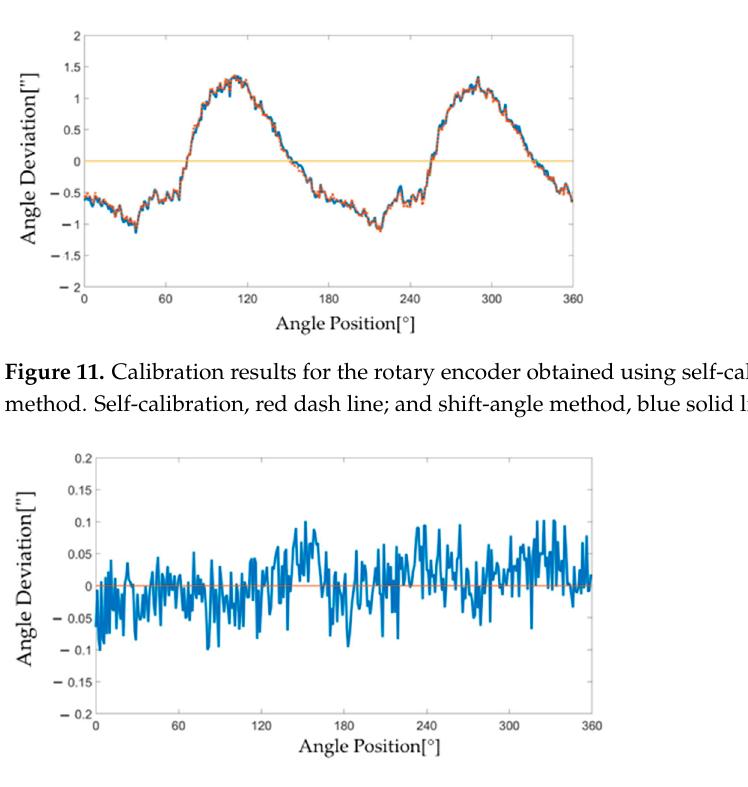
Figure 12. Difference in calibration results between self-calibration and shift-angle method.